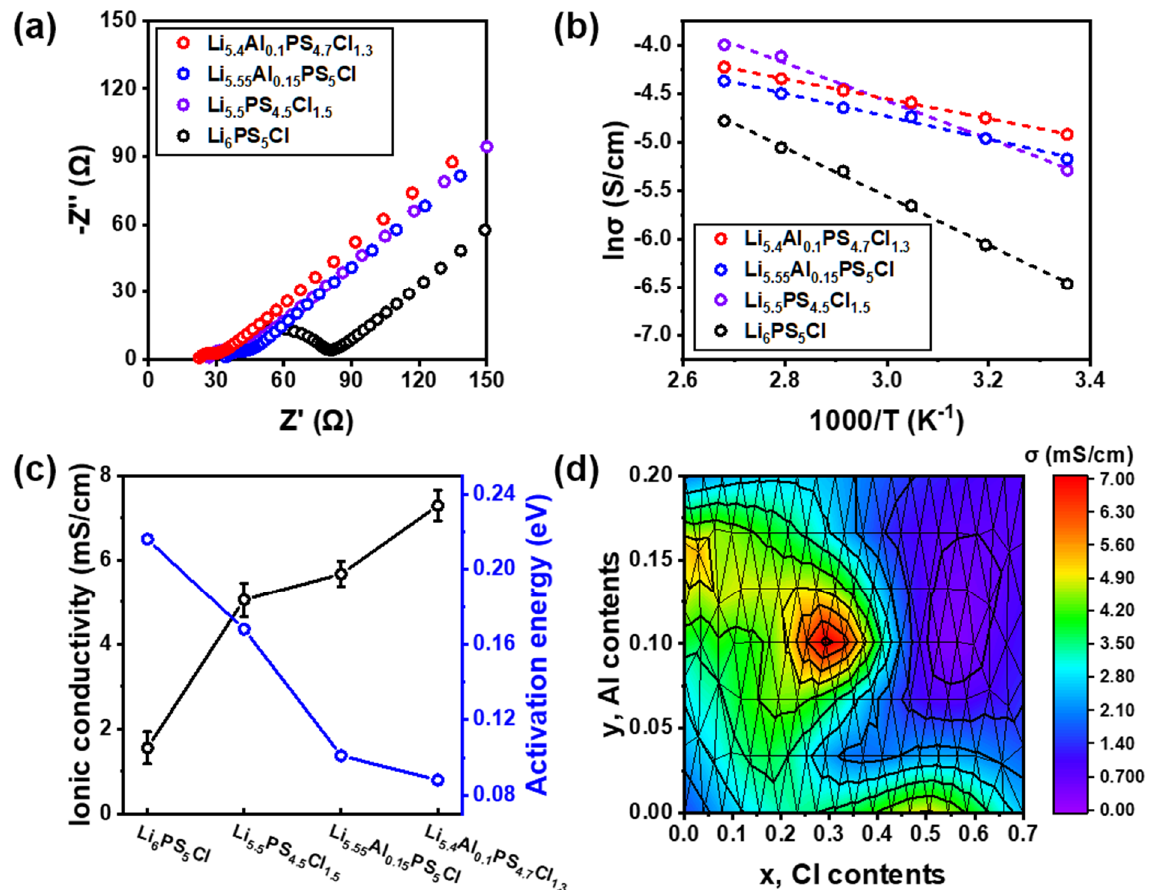
Figure 4. ( a ) Nyquist plots of Li 6 PS 5 Cl, Li 5.5 PS 4.5 Cl 1.5 , Li 5.55 Al 0.15 PS 5 Cl, and Li 5.4 Al 0.1 PS 4.7 Cl 1.3 electrolytes measured at 25 ◦ C. ( b ) Arrhenius plots of Li 6 PS 5 Cl, Li 5.5 PS 4.5 Cl 1.5 , Li 5.55 Al 0.15 PS 5 Cl, and Li 5.4 Al 0.1 PS 4.7 Cl 1.3 electrolytes measured in the range of 25 to 100 ◦ C. ( c ) E a and ionic conductivity of Li 6 PS 5 Cl, Li 5.5 PS 4.5 Cl 1.5 , Li 5.55 Al 0.15 PS 5 Cl, and Li 5.4 Al 0.1 PS 4.7 Cl 1.3 electrolytes. ( d ) Ionic conductivity of Li 6−x−3y Al y PS 5−x Cl 1+x (0 ≤ x ≤ 0.2, 0 ≤ y ≤ 0.7) electrolytes as a function of Cl and Al contents.